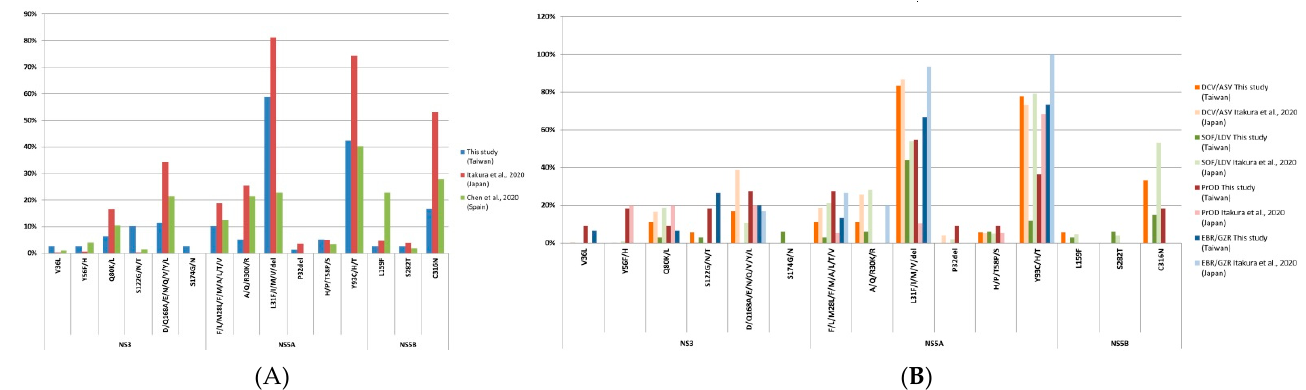
Figure 4. Comparison of RAS prevalence with other studies. ( A ) RAS prevalence compared to studies of Japan [23] and Spain [24]. ( B ) Detailed comparison of RAS prevalence for each DAA treatment to study results of Japan [23].